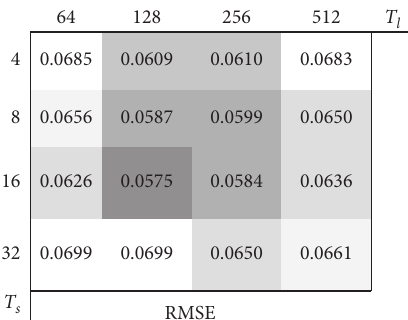
Figure 2: Performance of DWNet in Human Sports based on different short window size T colors to indicate the prediction effect. The better the prediction, the darker the color.